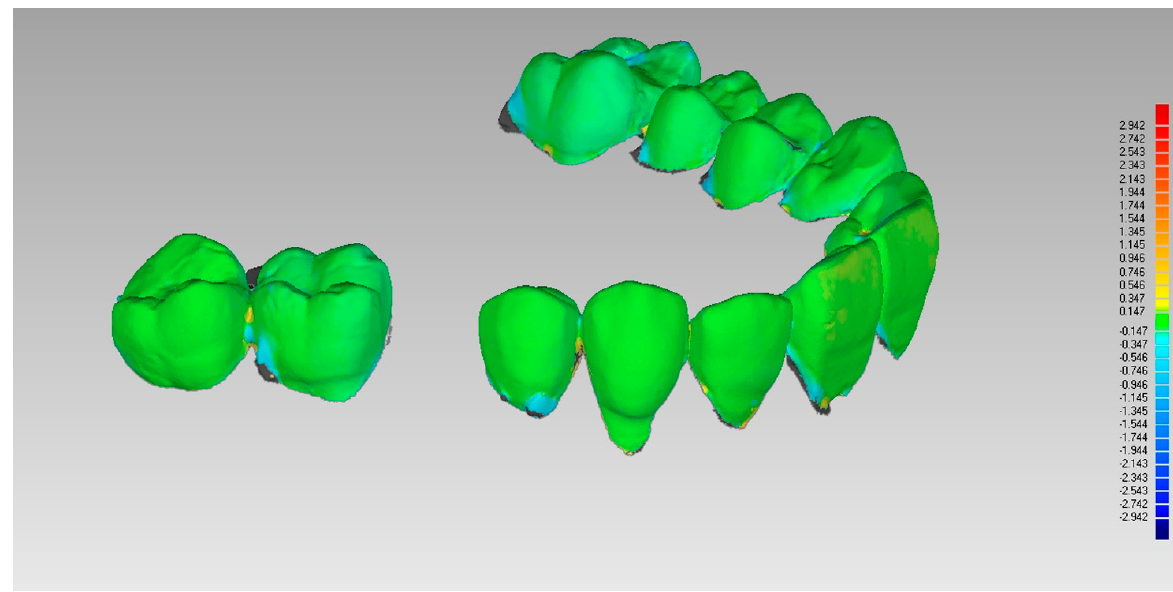
Figure 3. Superimposition of pre and post models based on the best fit of tooth surface.